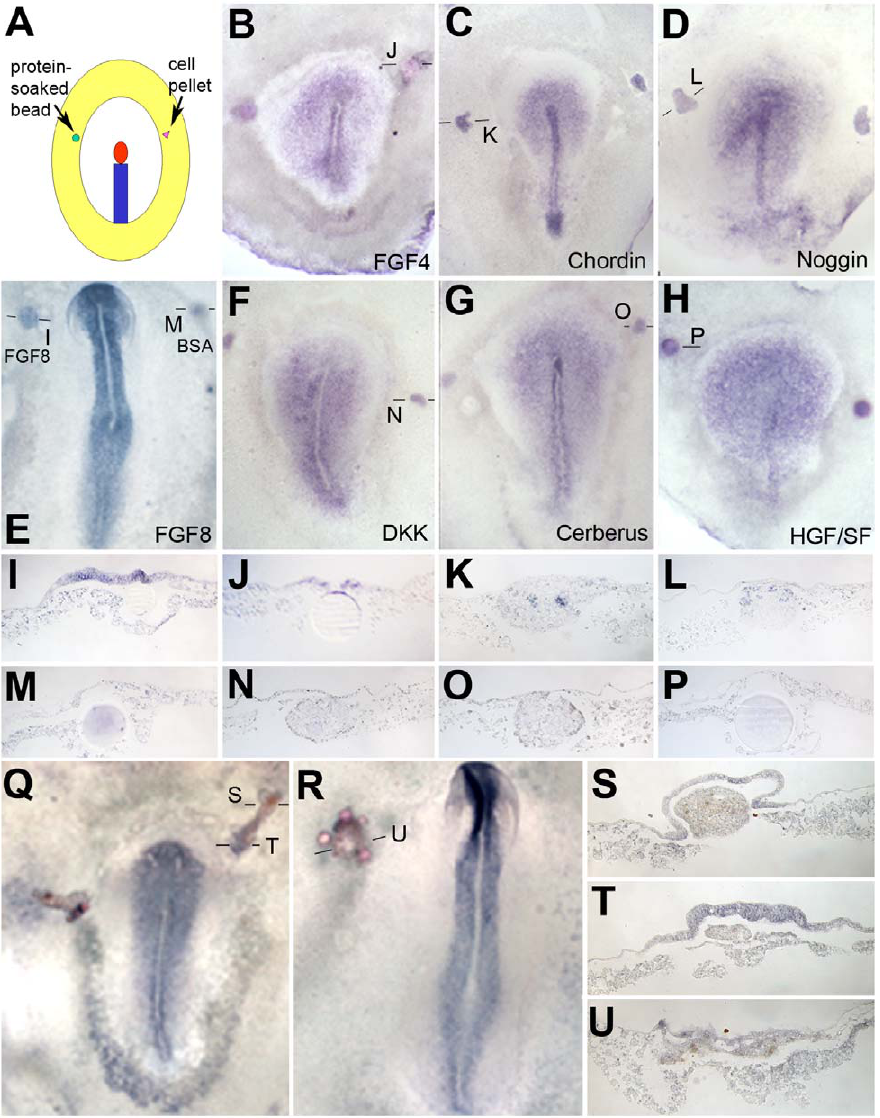
Figure 10. Regulation of Obelix by various secreted factors. A–P . The ability of various peptide factors to induce Obelix expression was tested by localapplicationofbeadssoakedintheproteinorpelletsofCOS-1cellstransfectedwithaconstructencodingthefactorintotheareaopacaofahostembryo (A). Examples of FGF4beads (B), Chordin (C) and Noggin (D) cells, FGF8/control beads (E), Dickkopf (F), Cerberus (G) cells and HGF/SFbeads (H) are shown. I–P show sections throughthe grafted region of the embryos in B–H at the levels indicated. Q–U . Co-transplantationof a quail Hensen’s node withbeads soaked in the FGF inhibitor SU5402 has little or no effect: Obelix is still induced (Q–U). Q shows a grafted embryo fixed after 6 hours, and R is an example of an embryogrownovernightafter thegraft.S–Uaresectionsthroughthese embryos atthelevels indicatedinQandR. Quail cellsarestainedwithQCPN(brown). Note that some probes attach non-specifically to some types of beads and to COS cell pellets (eg. panels K–H).